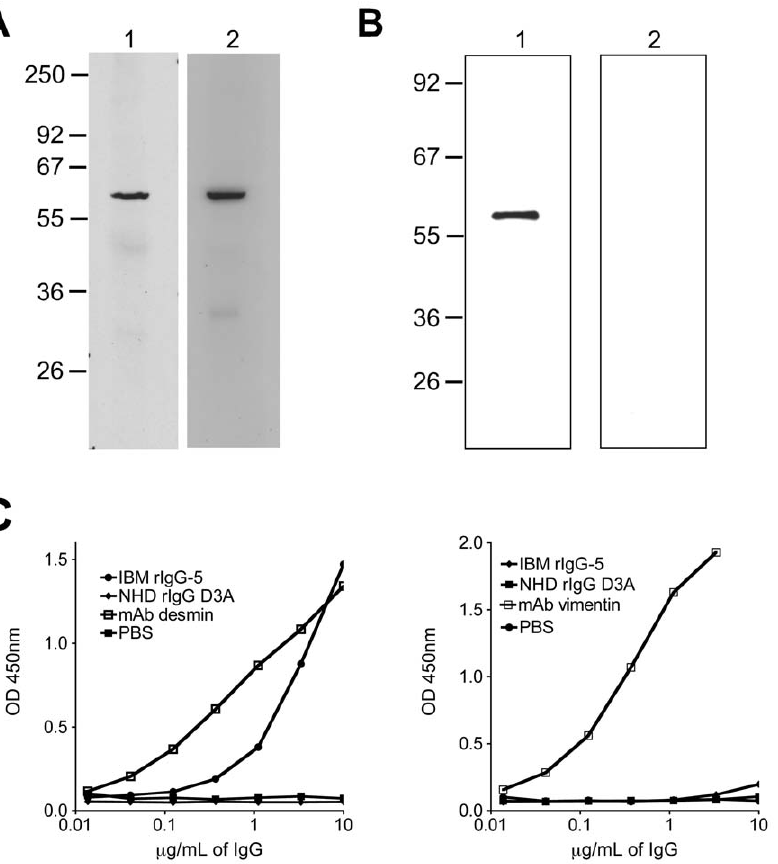
Figure 5. Immunoassays evaluating recombinant IgG binding to Desmin. Independent immunoassays were used to demonstrate that recombinant immunoglobulin derived from an IBM muscle-associated plasma cell (rIgG-5) binds to human Desmin. (A) Human muscle homogenates were resolved by SDS-PAGE then transferred to membranes that were probed with IBM-derived recombinant rIgG-5 (lane 1) or a commercial anti- Desmin monoclonal antibody (lane 2). (B) Purified human Desmin was resolved by SDS-PAGE then transferred to membranes that were probed with IBM-derived rIgG-5 (lane 1) or rIgG-D3a (lane 2), which was derived from an immature antigen-inexperienced peripheral human B cell. (C) ELISA assays demonstrating IBM-derived immunoglobulin (rIgG-5) binding to the human muscle protein Desmin. ELISA plates were coated with either Desmin (left panel) or Vimentin (right panel) then probed with IBM rIgG-5 and a rIgG (D3a) derived from a single B cell from a normal healthy donor. Monoclonal antibodies (mAb) specific for each antigen were used as positive